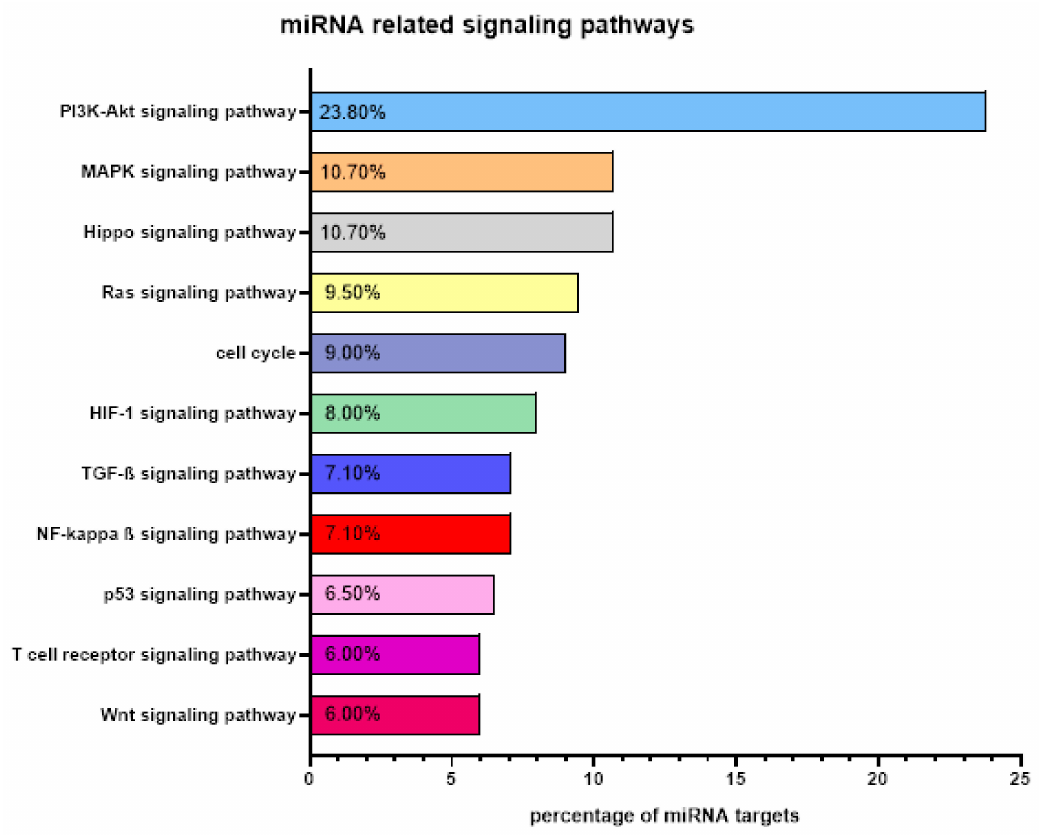
Figure 3. Targets of miRNAs in MDS and AML. MiRNAs can target various intracellular pathways that are necessary for a broad range of biological and pathophysiological processes including transcriptional and translational regulation, control of immune responses, and tumor immune surveillance. The major miRNA-related signaling pathways in MDS and sAML are